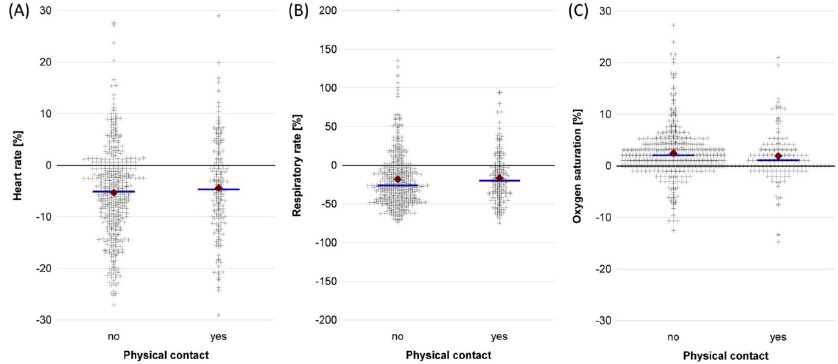
Figure 3. Relative change of vital signs during music therapy sessions in 40 stable preterm infants receiving music therapy with (159 sessions) and without (444 sessions) physical contact at the University Hospital Essen between October 2018 and July 2021. A negative value indicates a lower, and a positive value a higher, post-therapy value compared to the baseline value. + signs = individual measurements; blue line = median; red diamond = mean. ( A ) Heart rate. ( B ) Respiratory rate. ( C ) Oxygen